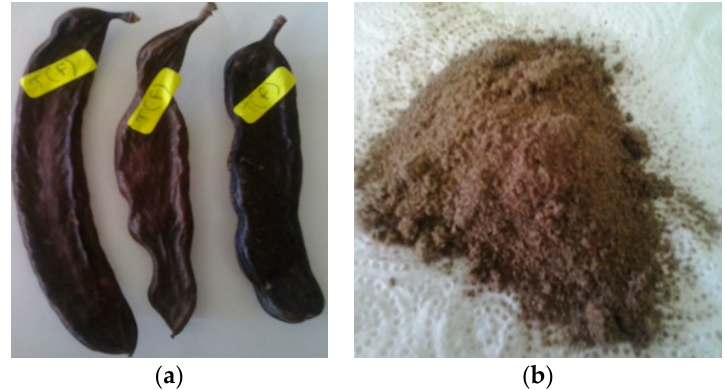
Figure 7. ( a ) Carob pods; ( b ) final Carob byproducts powder.